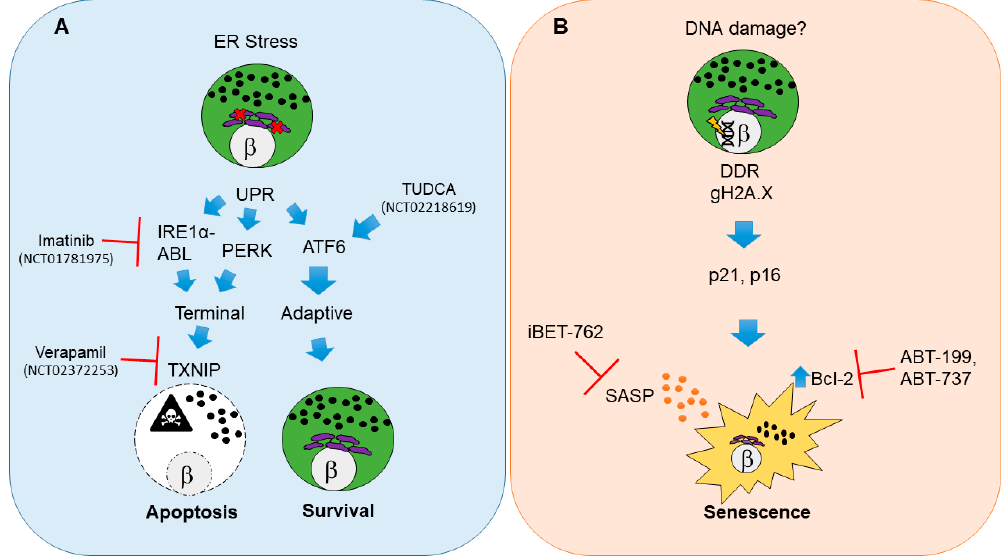
Figure 1. Molecular pathways and therapeutic targets for beta cell unfolded protein response (UPR)-mediated apoptosis and senescence in type 1 diabetes (T1D). ( A ) Beta cell apoptosis in T1D results from persistent endoplasmic reticulum (ER) stress that leads to activation of UPR master regulators IRE1 α , PERK and ATF6. IRE1 α mediates its functions through its RNAse and kinase activities that are potentiated by the Abelson tyrosine-protein kinase (ABLs). The balance of each UPR regulator dictates the outcome on beta cell fate. Unrelieved ER stress signals through IRE1 α and PERK and